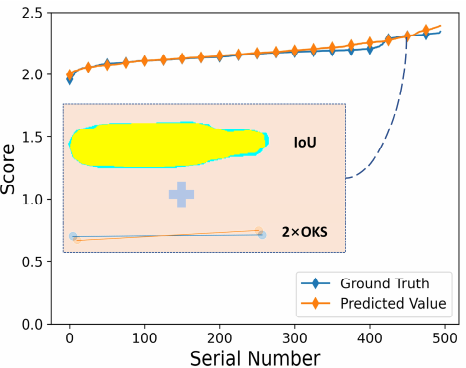
Figure 14. Prediction of scoring network on the validation set.